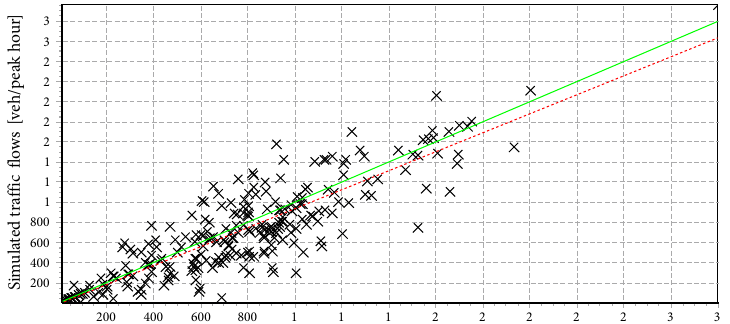
Figure 1. Assignment analysis